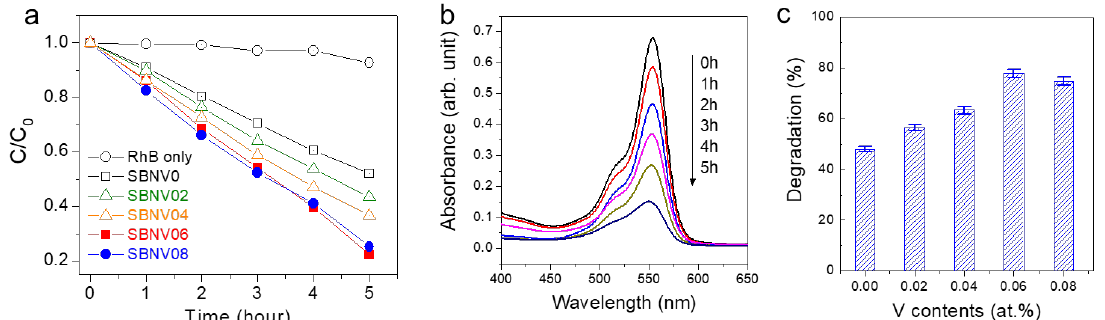
Figure 6. Visible light (VIS)-induced photocatalytic activity of SrBi 2 Nb 2 − x V x O 9 powders with x = 0, 0.02, 0.04, 0.06, and 0.08 (SBNV0, SBNV02, SBNV04, SBNV06, and SBNV08, respectively), under irradiation with a halogen lamp having a 420 nm cut-o ff filter: ( a ) Concentration change profiles with irradiation time. ( b ) Variation of the absorbance of the RhB dye solution with time for the SBNV06 (See Figure S3 for the others). ( c ) Comparison of RhB dye decomposition e ffi ciency after 5 h. The error bar was obtained from three measurements of each sample.